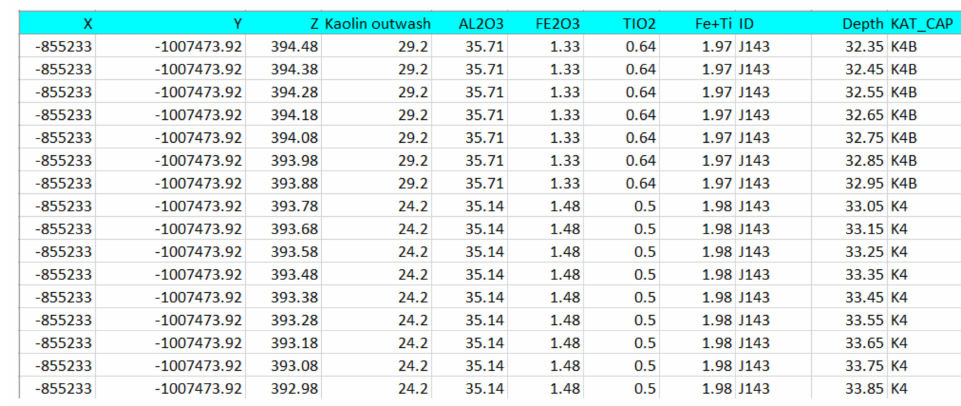
Figure 3. Part of the data for next processing.